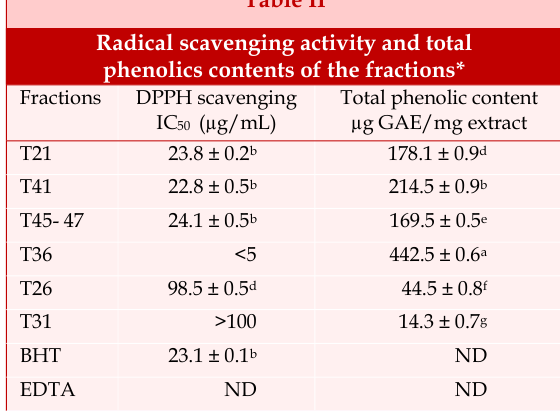
*Values represent averages ± standard deviations for triplicate experiments. Values in the same column with different superscripts are significantly (p<0.05) different, ND: Not determined